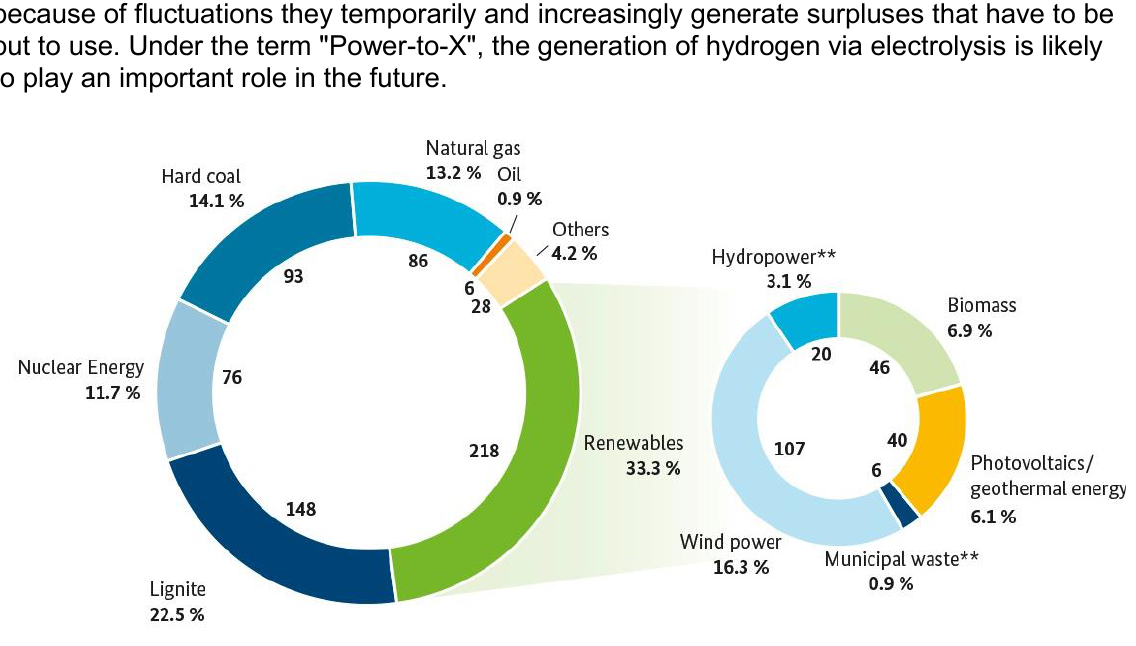
Figure 2 . Energy data - gross electricity generation in Germany 2017 (total 654.8 TWh)